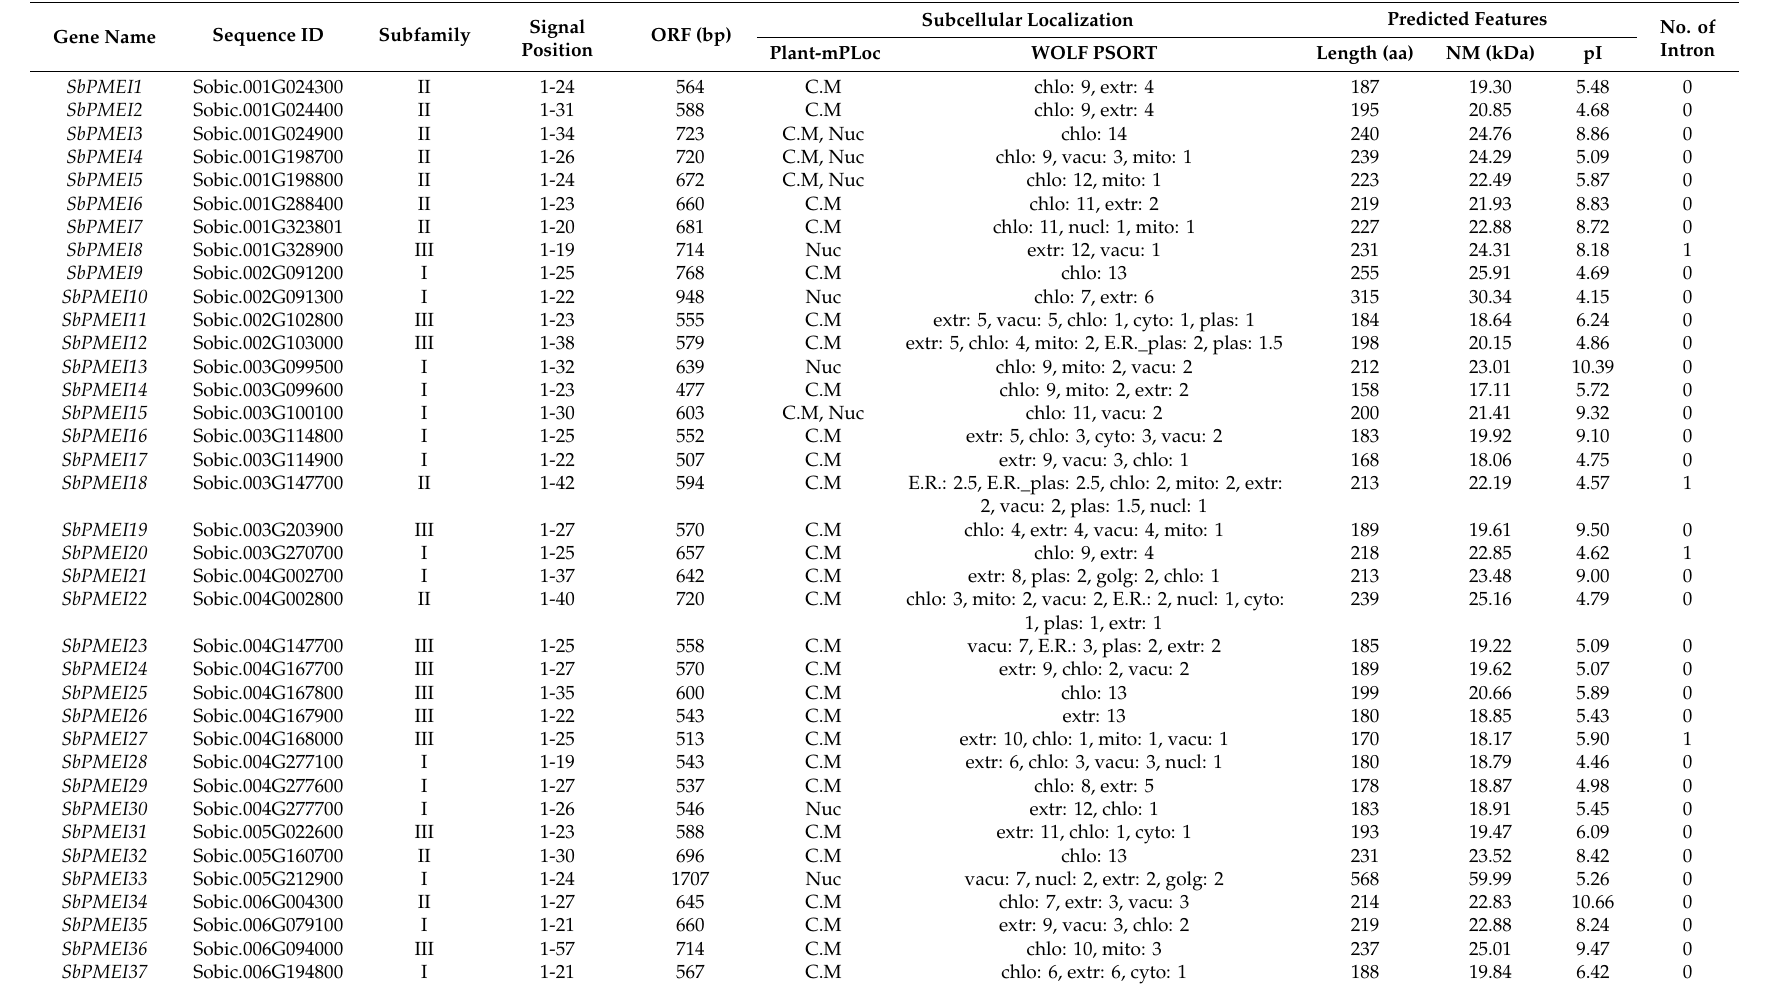
Table 1. Characteristics of fifty-five PMEIs identified in the S. bicolor